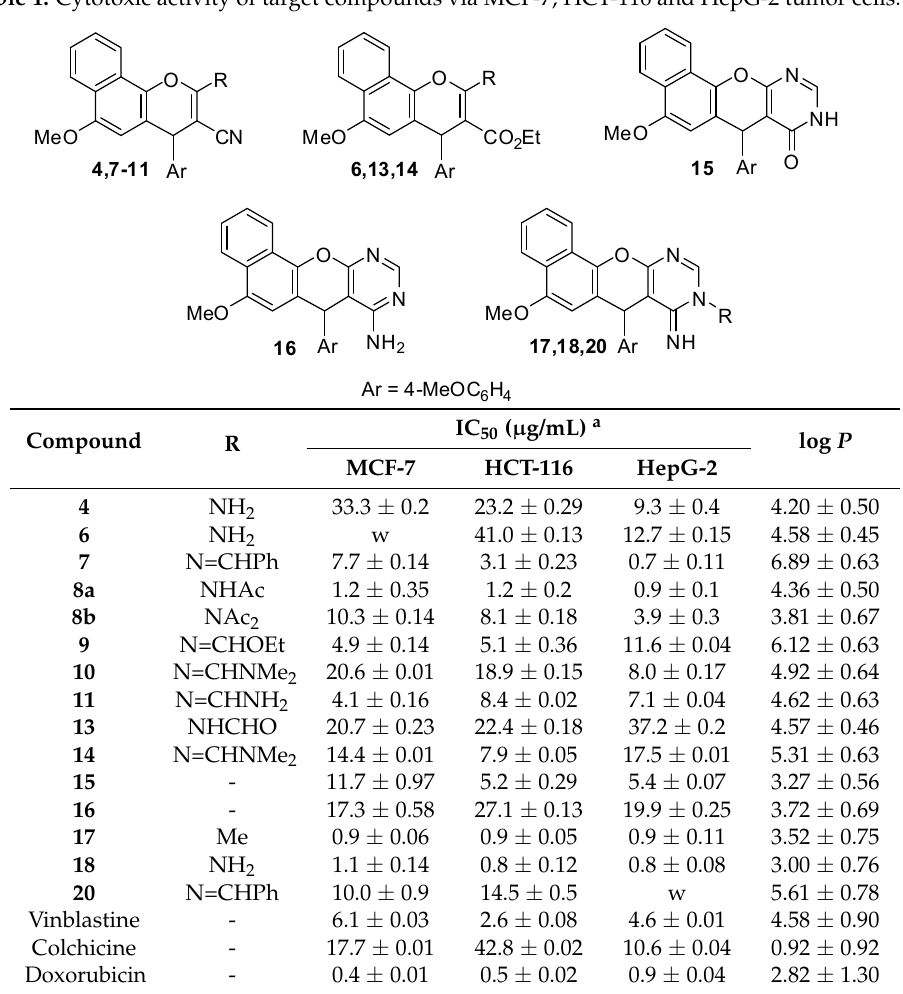
Table 1. Cytotoxic activity of target compounds via MCF-7, HCT-116 and HepG-2 tumor cells.